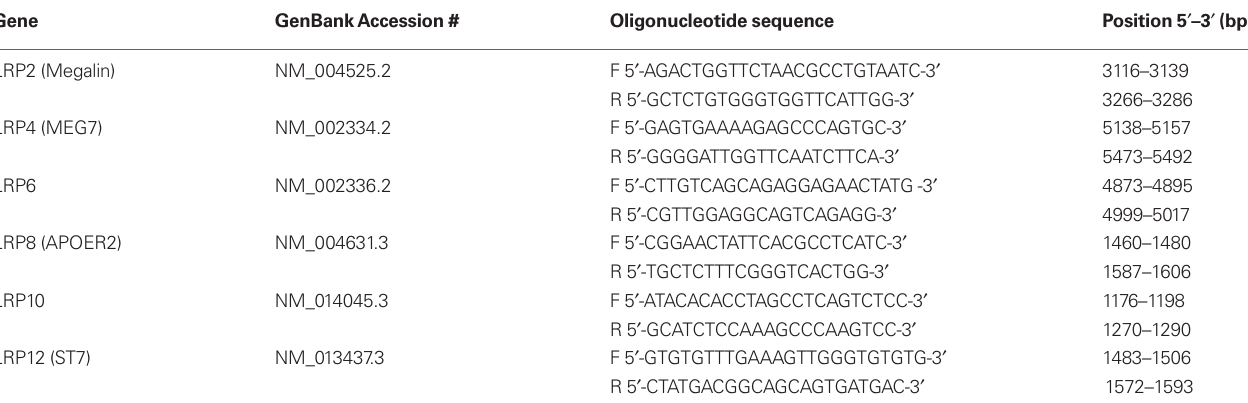
Table 3 | A summary of the oligonucleotide primers used for real-time PCR analysis of LRP expression. Commonly used synonyms are provided in